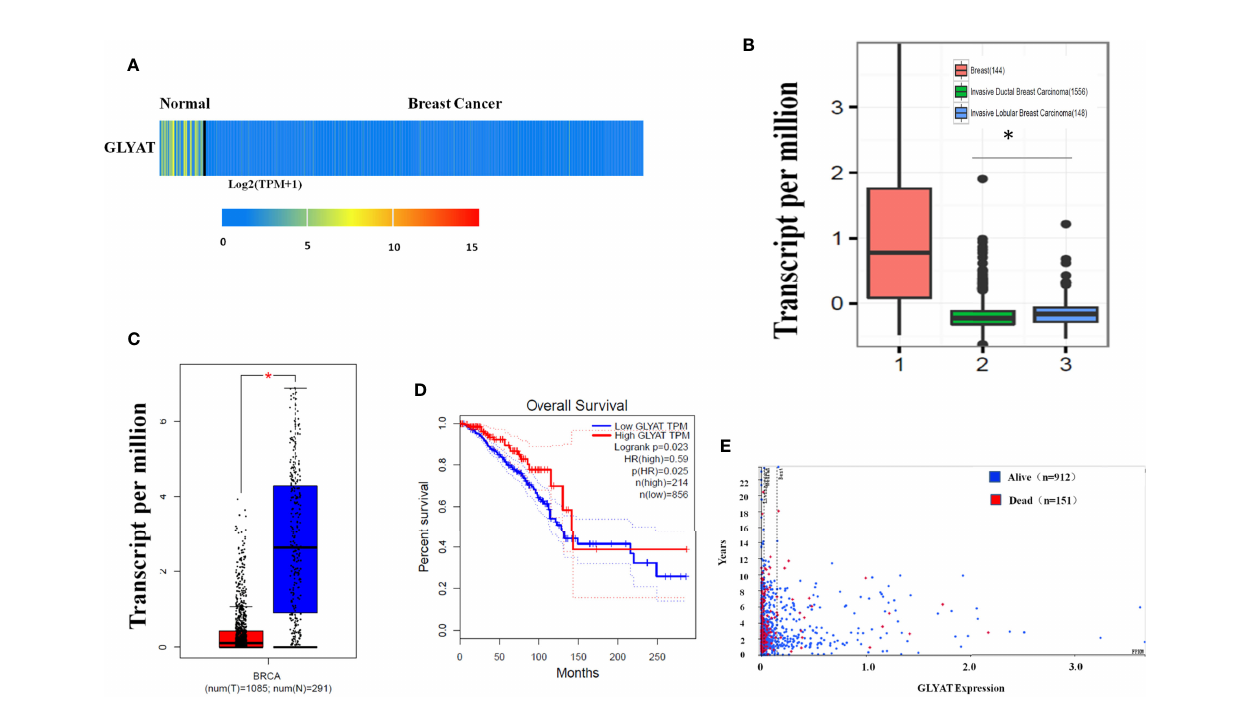
FIGURE 1 | Characterization of GLYAT expression pro fi ling in human breast cancer. (A) Heatmaps showing the clustering patterns of differentially expressed GLYAT between normal and breast cancer specimens. (B) Box plot analysis of the GLYAT mRNA levels in IDBC, ILBC and normal breast tissue samples. (C) Box plot analysis of the GLYAT mRNA levels in BC and NC tissues. T, tumor; N, normal. (D, E) Kaplan-Meier plots of OS in BC patients with different levels of GLYAT. * p <